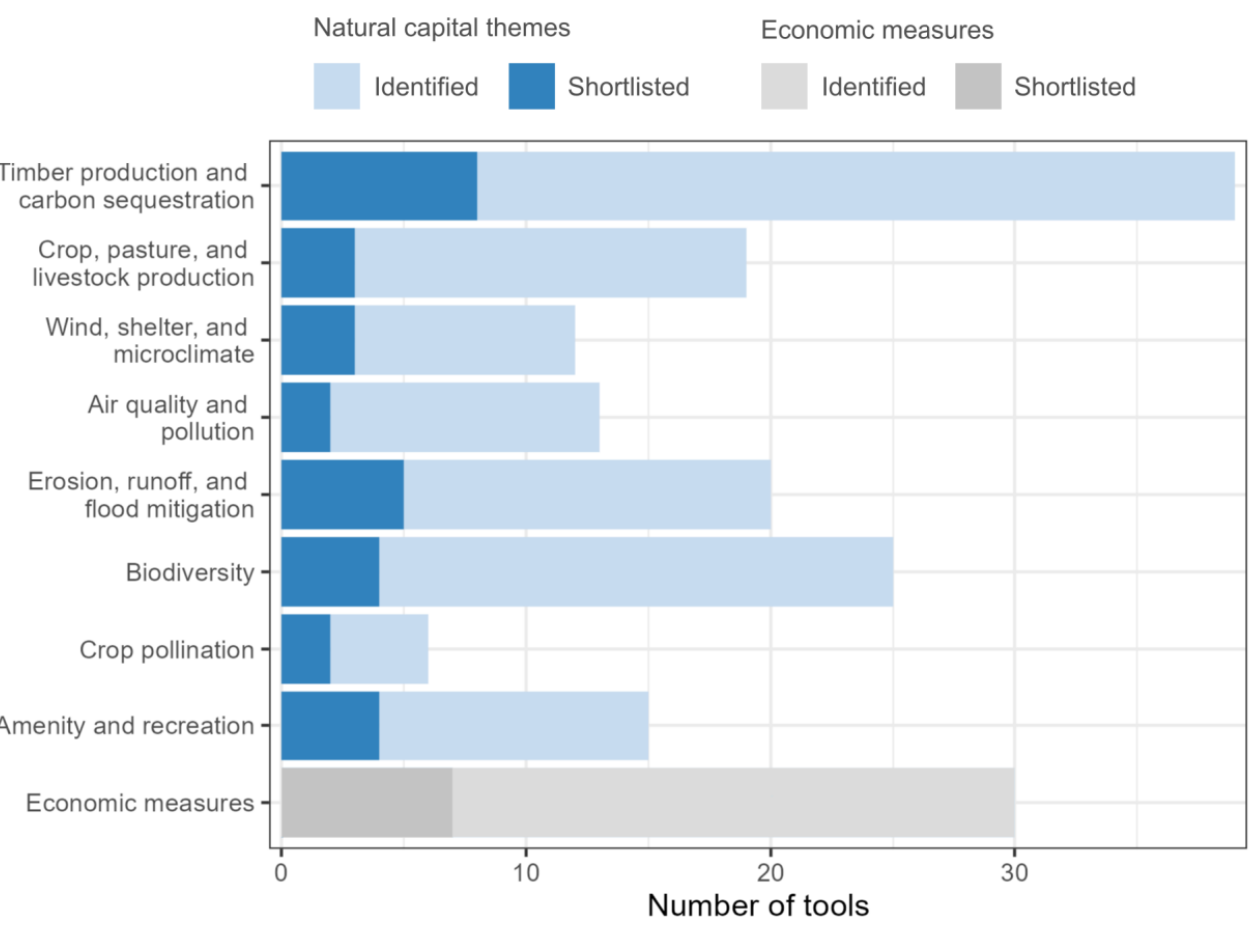
Figure 1. Total number of identified and shortlisted tools that quantify each of the selected natural capital benefits of agroforestry, in addition to those with the capability for calculating economic